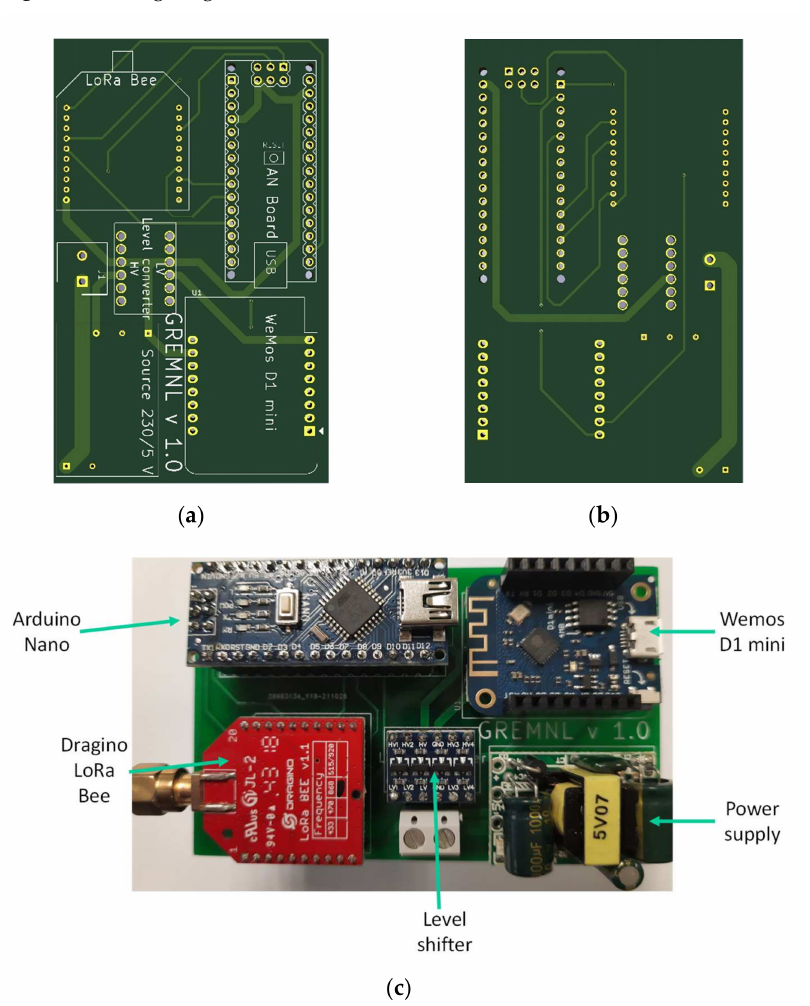
Figure 4. Printed circuit board (PCB) of the GREMNL with battery power supply: ( a ) front side, ( b ) back side and ( c ) assembled with real